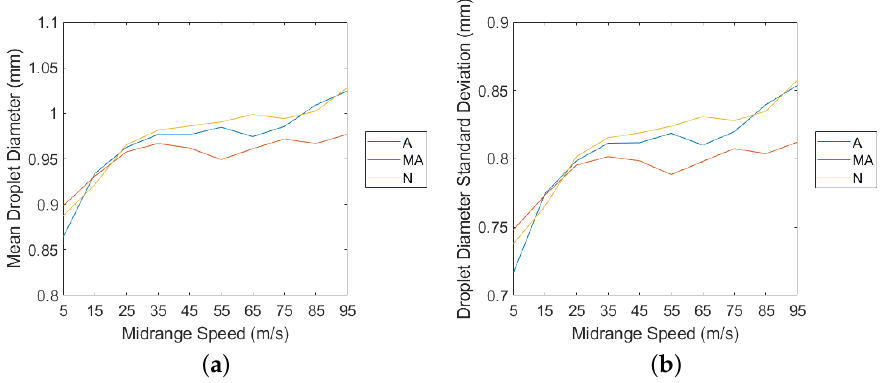
Figure 11. The variation of mean seen in ( a ) and standard deviation in ( b ) for droplet diameter with the midrange tip speed of each bin for stations A, MA and N, as calculated by the